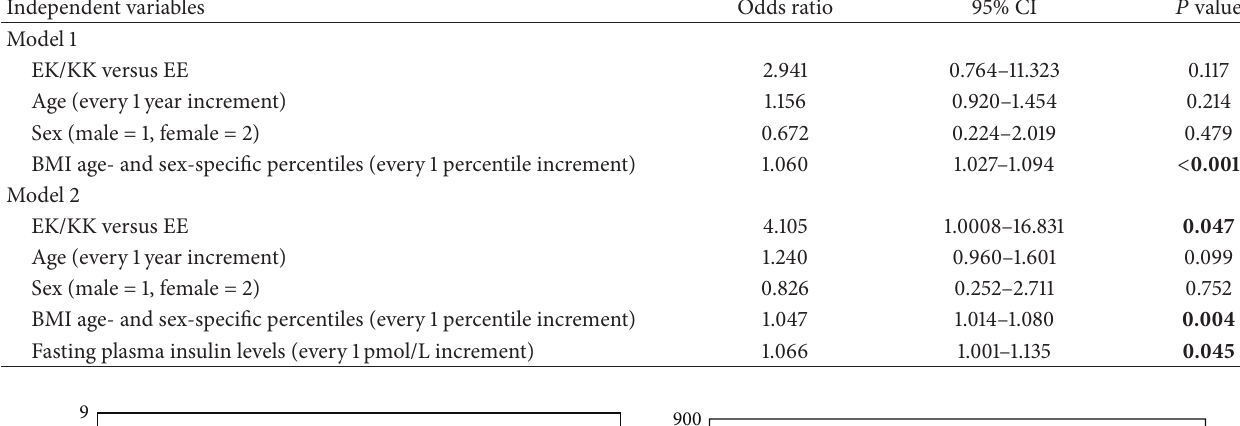
Table 3: Logistic regression analysis with type 2 diabetic status as dependent variables, age, sex, BMI age- and sex-specific percentiles, and genotype of E23K polymorphism in Kir6.2 as independent variables.